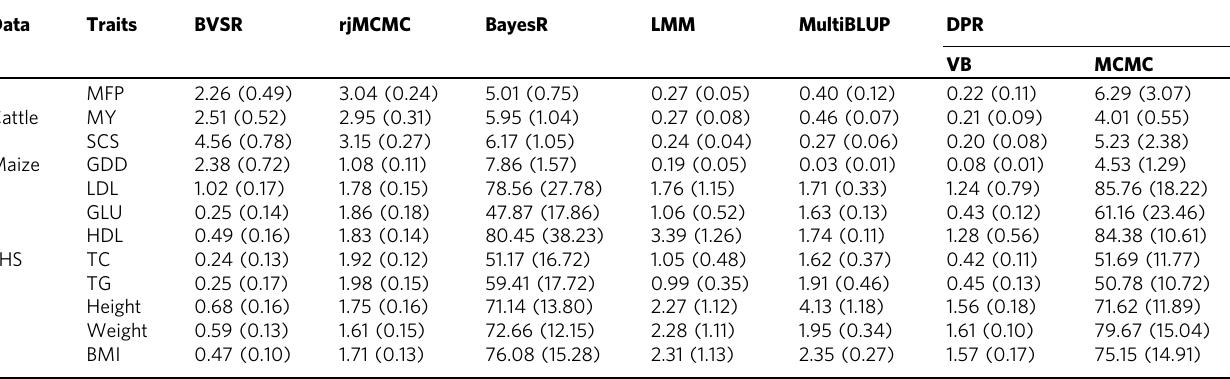
Table 3 Mean computational time of the seven methods in the model fi tting stage for 12 traits across three data sets Data